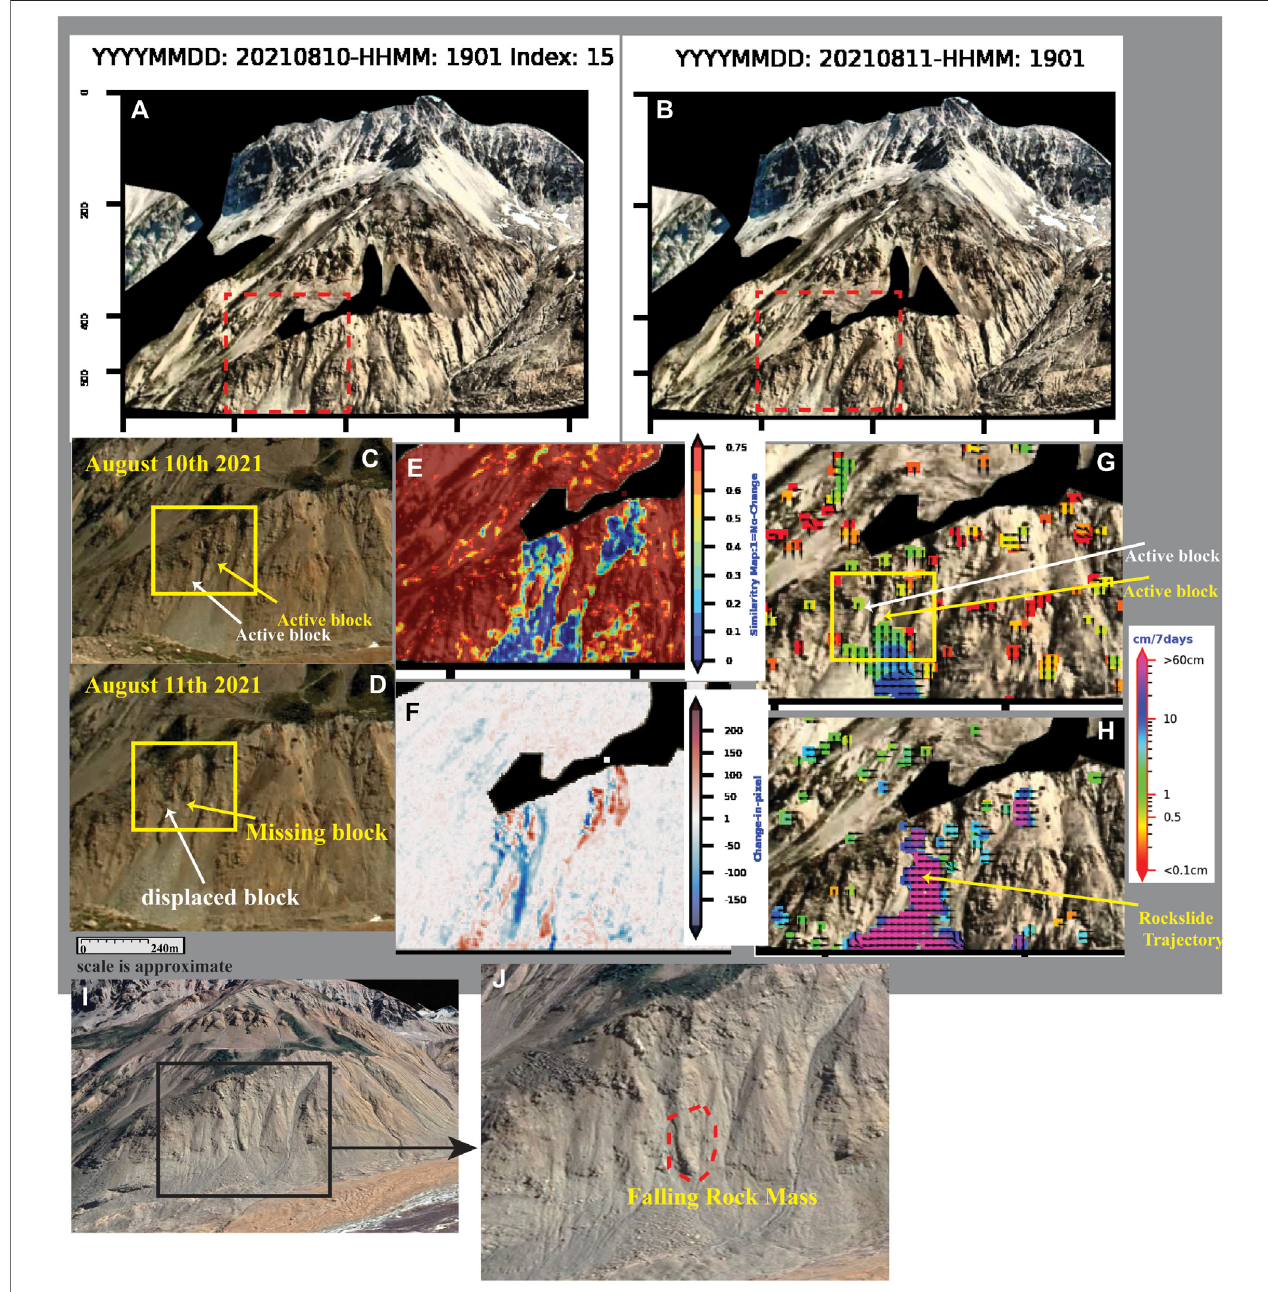
FIGURE12| Smalllandslideidenti fi cation withAkh-Defousingcombinedstaticand dynamic changedetection methodsforthePlinthPeakslope. (A) Imagetaken on 10 August 2021, at 11 a.m. (B) Image taken on 11 August 2021, at 11 a.m. (C) Zoomed window of panel (A) focused on the unstable region before the rockslide failureoccurred on10August 2021. (D) Zoomed window ofpanel (B) focusedon theunstableregionafter the rockslide failure occurred on 11August 2021. (E) Results of the structural similarity index map. Note the rockslide and change identi fi cation obtained from structural similarity map compared to image differencing. (F) Results of image differencing showing areas of change and rockslide events. (G) Displacement rate for the Plinth Peak slope calculated from triplets of images 7 days before the 11 August 2021, rockslide event. (H) Reconstructed trajectory path of the rockslide. The colour bar for panels (G,H) is log scale. (I) High resolution Google Earth imagery showing the least stable part of Plinth Peak slope. (J) Zoomed window of panel (I) show approximate size and location of the failing rock mass on 11 August 2021.